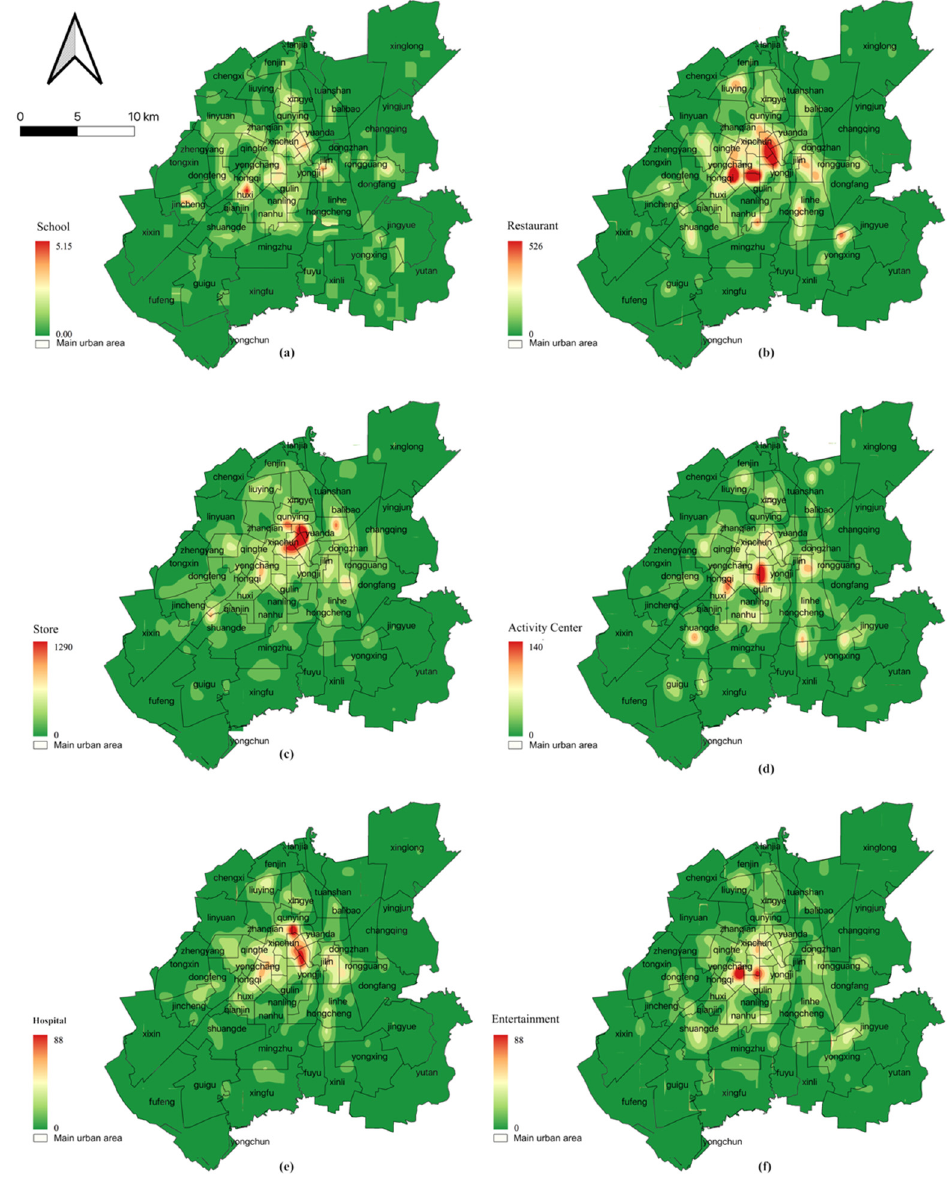
Figure 9. Kernel density of various service facilities. ( a ) school; ( b ) restaurant; ( c ) store; ( d ) activity center; ( e ) hospital; ( f ) entertainment.